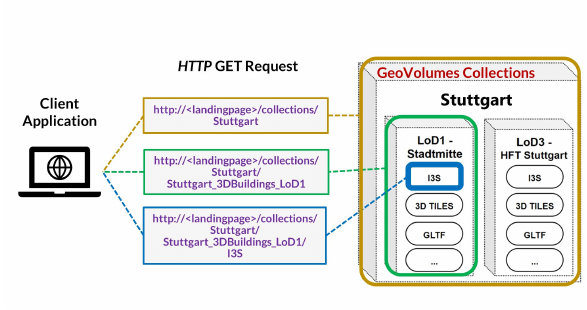
Figure 2. The OGC API 3D GeoVolumes hierarchical resource architecture and its associated HTTP resource path.